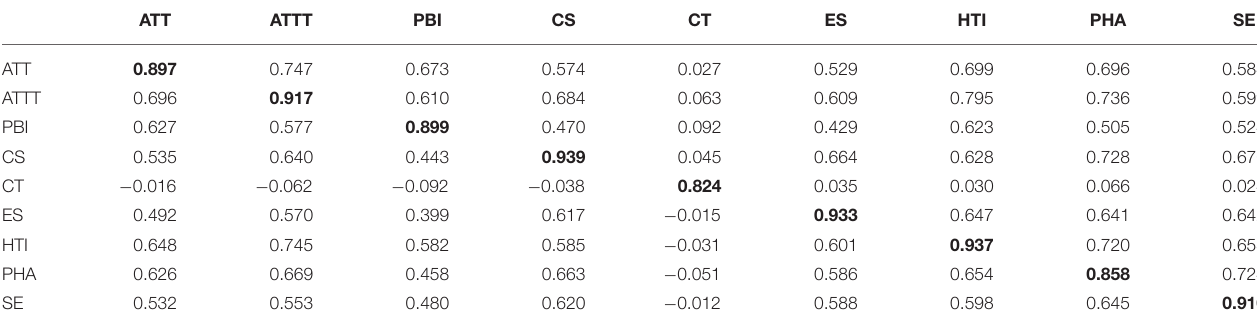
TABLE 3 | Correlations, AVE values, and HTMT ratios.